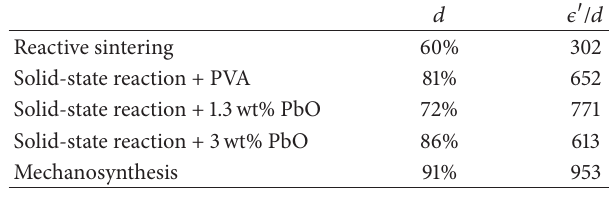
Table 1: Relative density ( 𝑑 ) and normalized dielectric constant ( 𝜖 󸀠 / 𝑑 ) at room temperature and 1kHz measured on PYN-PT ceramics with 60% PbTiO 3 obtained by the various investigated synthesis techniques. For the solid-state technique, PVA or PbO were used as binders.